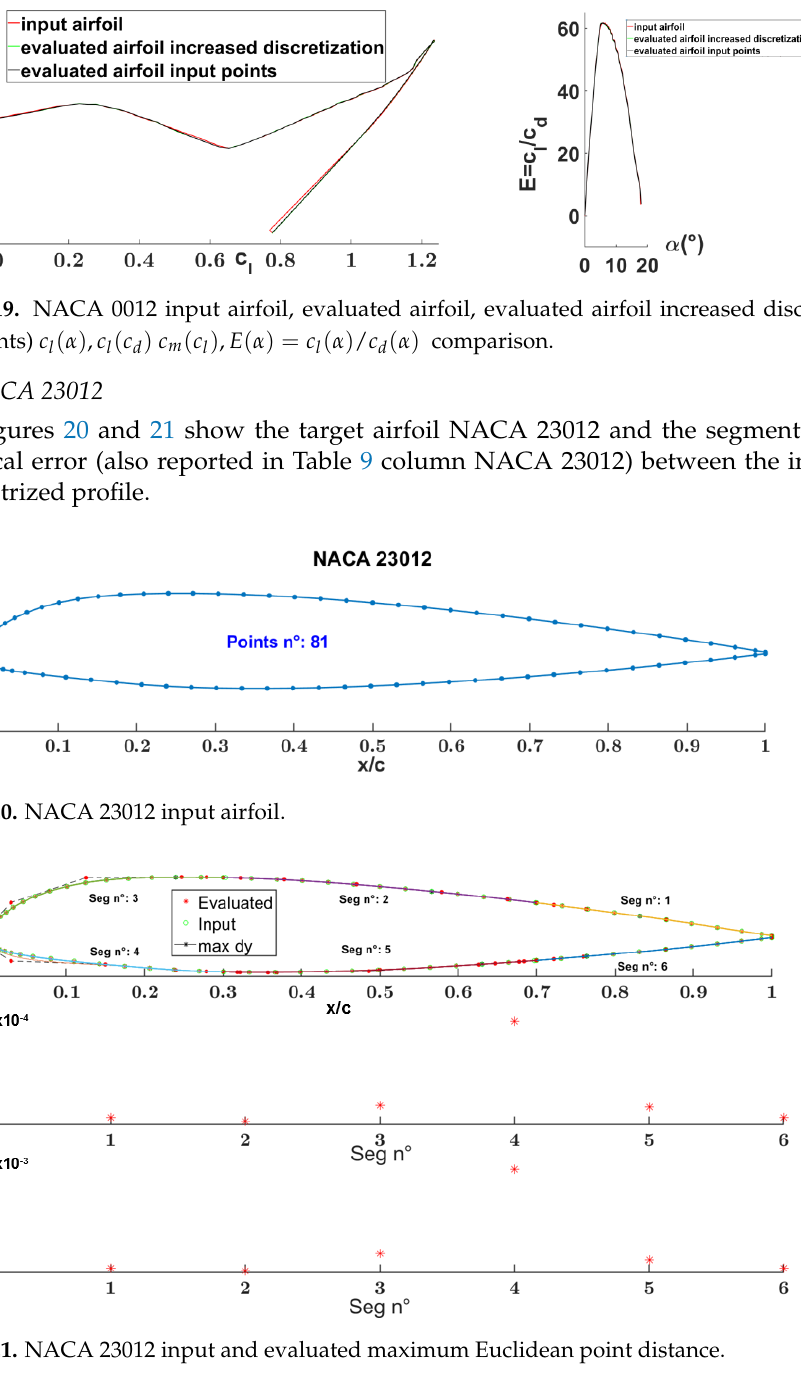
Figure 21. NACA 23012 input and evaluated maximum Euclidean point distance. Figure 22 shows the comparison of the aerodynamic curves 𝑐 (𝛼), 𝑐 (𝑐 ) 𝑐 (𝑐 ), 𝐸(𝛼) = 𝑐 (𝛼) 𝑐 (𝛼)⁄ between the target NACA 23012 and para- 𝑙 𝑙 𝑑 𝑚 𝑙 𝑙 𝑑 metrized airfoil.